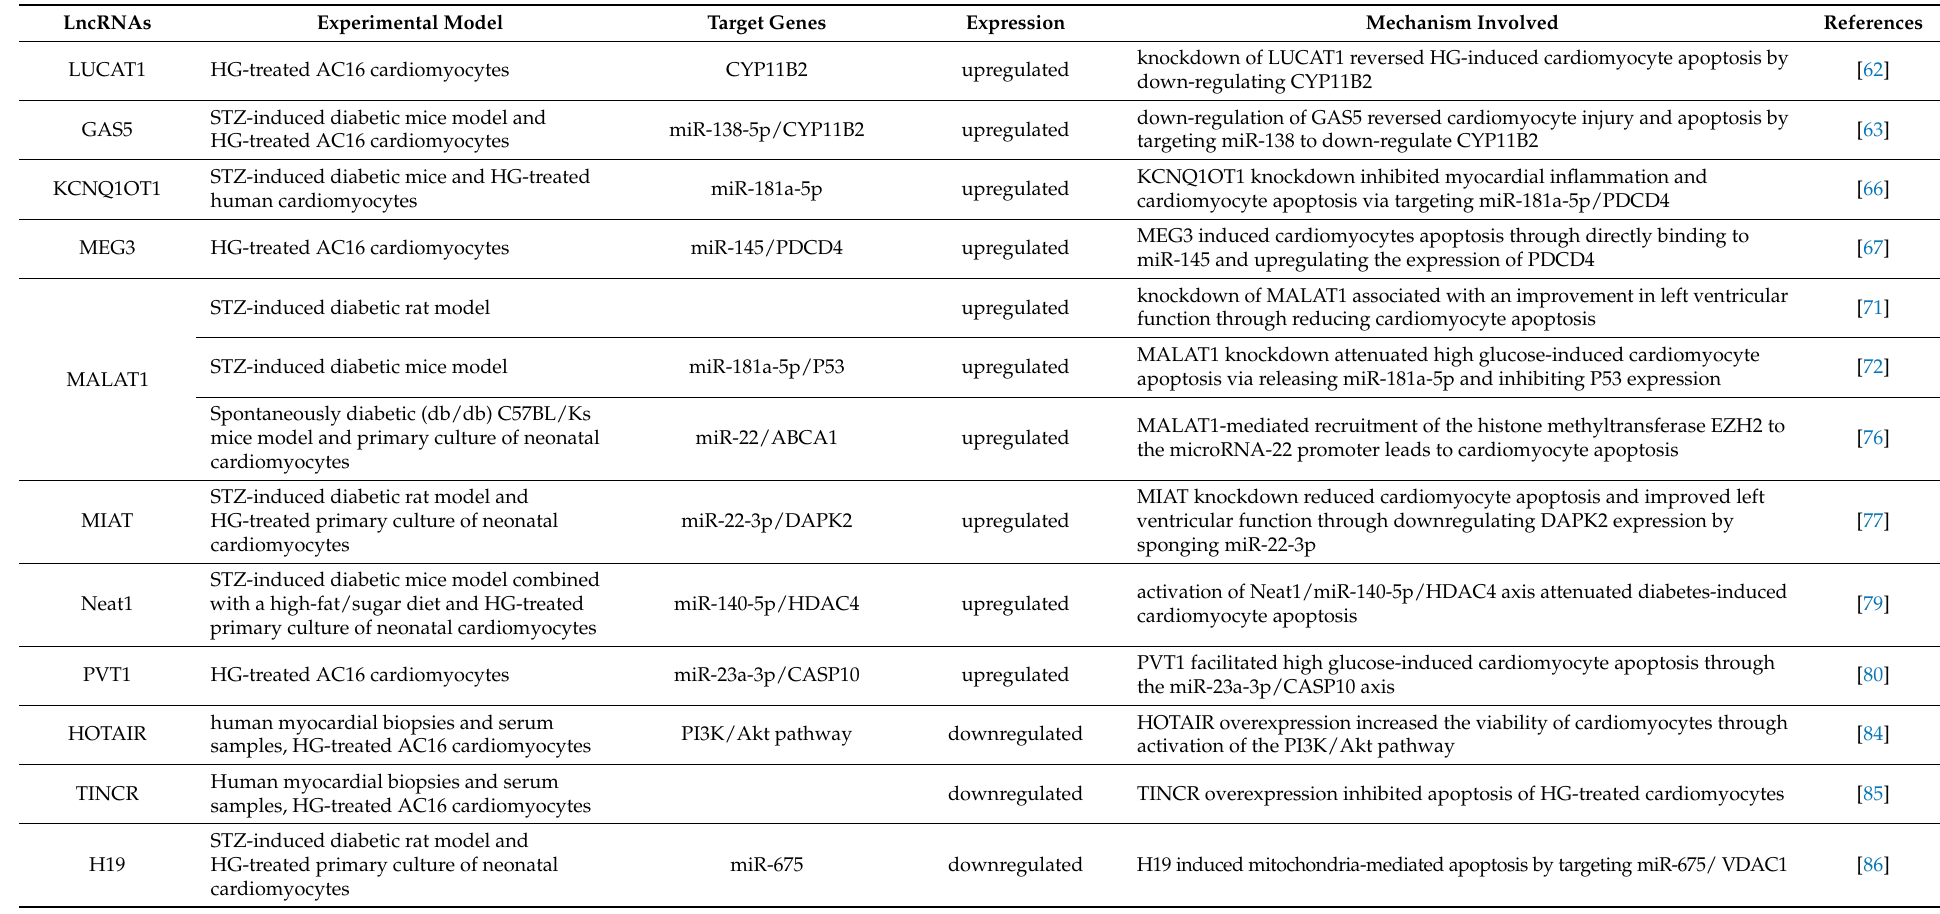
Table 1. Long non-coding RNAs (lncRNAs) involved in the pathogenesis of cardiomyocyte apoptosis in diabetic cardiomyopathy